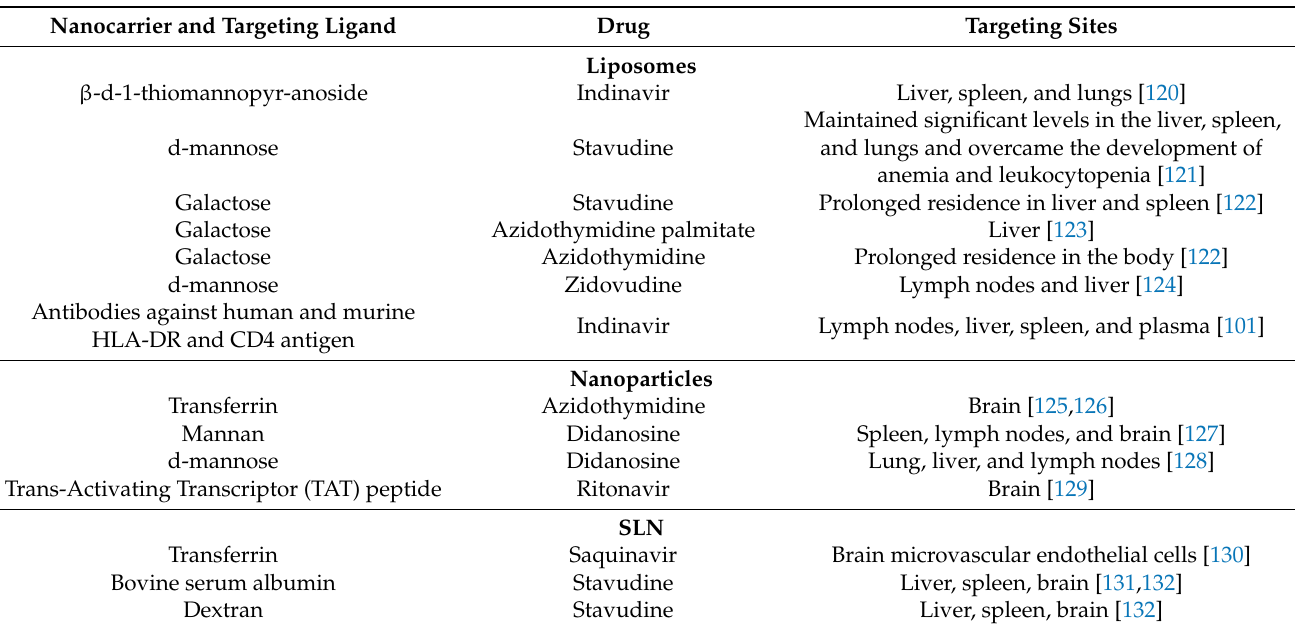
Table 3. Drug delivery systems are exploited for targeted delivery of anti-HIV1 drugs to reservoir